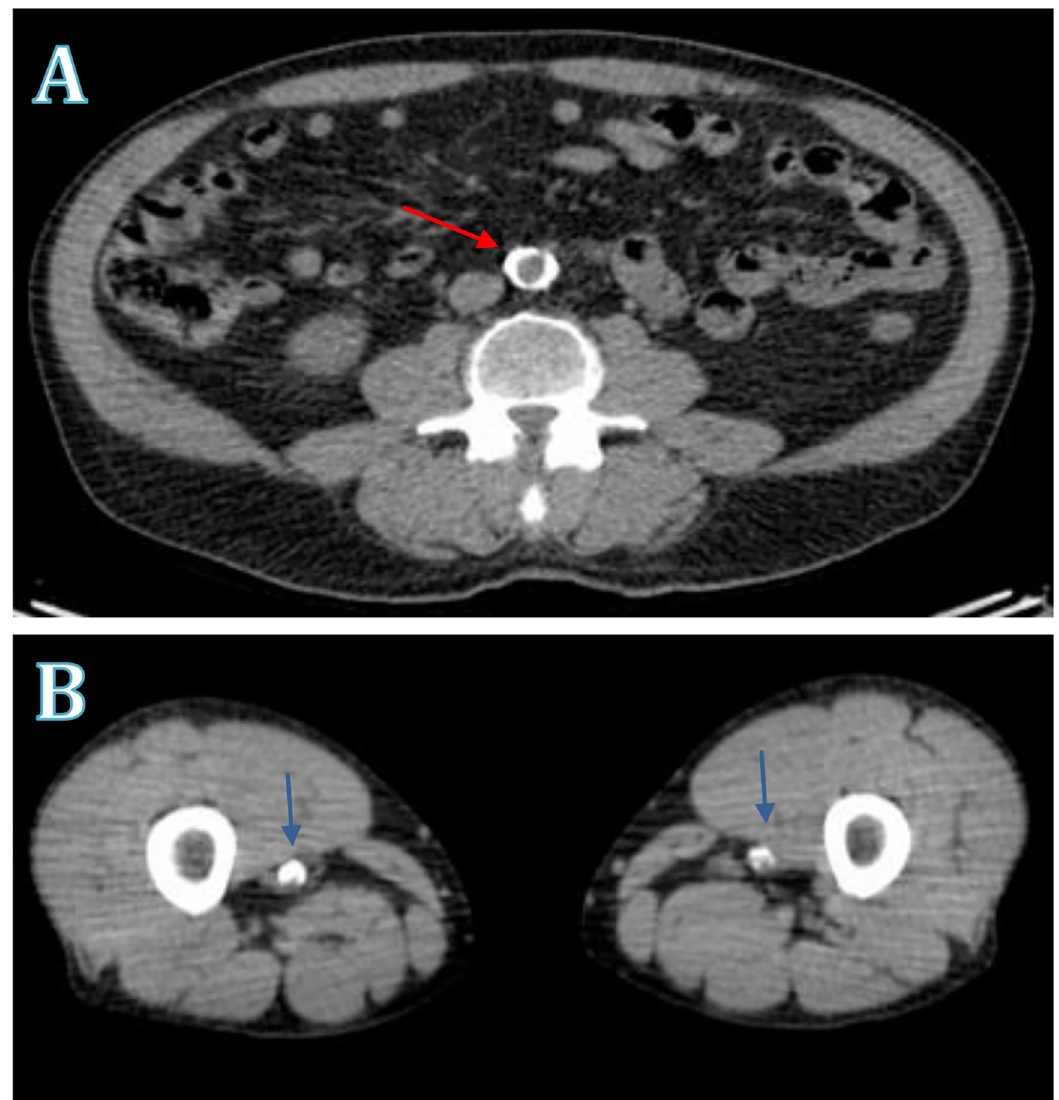
Fig 1. Arterial calcification. Unenhancedmulti-slicedcomputed tomographyimages of arterial calcification (A) circumferential calcification of the distal abdominalaorta (B) calcificationof both distal superficial femoral arteries at the level of the adductor hiatus with evidenceof significantintraluminalstenotic plaquedisease.Arrows identify areas of calcification.